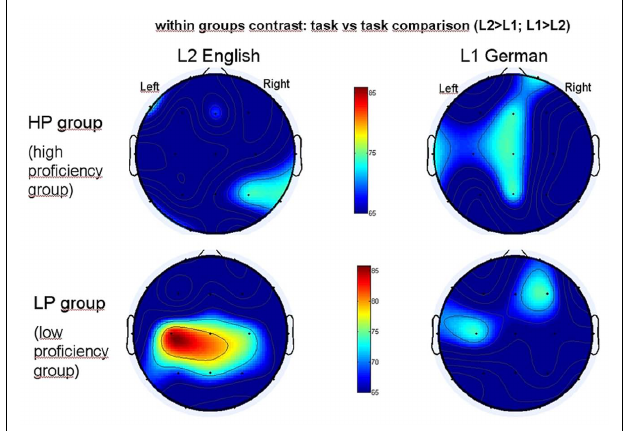
FIGURE 4 | Brain maps depicting gamma synchronization measured by phase lag index (PLI) during first (L1, right panel) and second (L2, left panel) language processing in the high proficiency (HP) group (upper row) and low proficiency (LP) group (lower row). Task versus task comparisons measuring within group differences at p < 0.05, corrected for multiple comparisons. Brain maps are to be seen from bird’s eye perspective, with the frontal parts showing toward top of the page. Red color in color bar indicates percentage of electrodes’ pertinence to a given cluster.